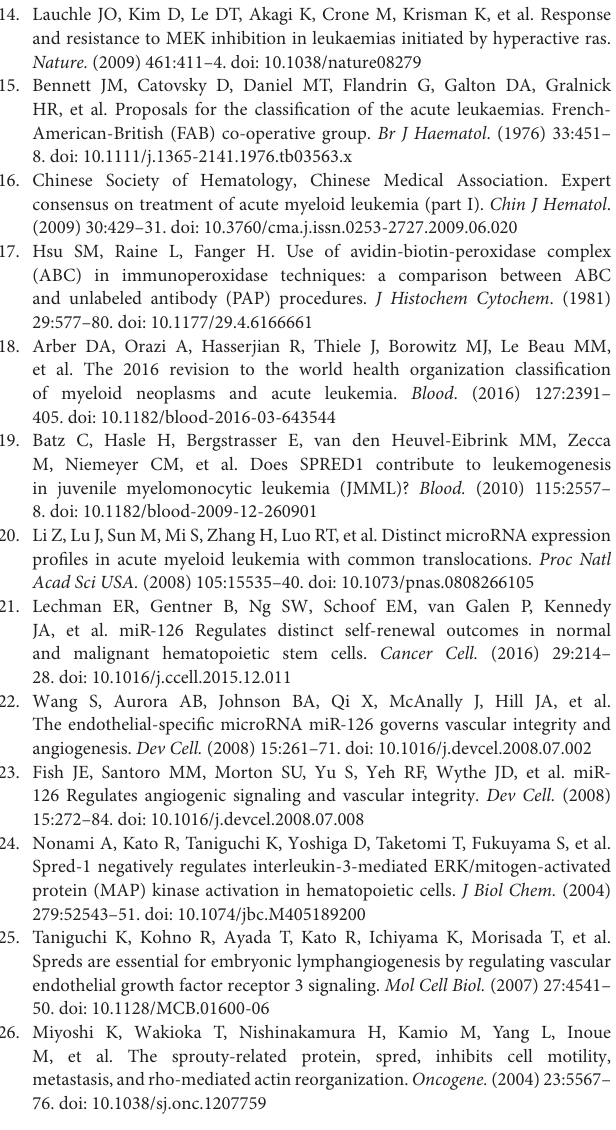
SFigure 1 | FISH hybridization with home-brewed SPRED1 probes named RP11-644D16 (SG, 15q14) and RP11-477P17 (SO, 15q14). Two green signals and two orange signals were observed, suggesting no deletion of SPRED1. SFigure 2 | The expression of SPRED1 in AML cell lines. (A) The mRNA expression levels of SPRED1 in AML cell lines THP-1, OCI-AML2, OCI-AML3, Kasumi-1, HL-60, and NB4 were determined by RT-PCR; (B) the protein expression of SPRED1 in AML cell lines THP-1, OCI-AML3, and HL-60 were assayed by Western blot. STable 1 | Primers used to amplify SPRED1 exons (coding